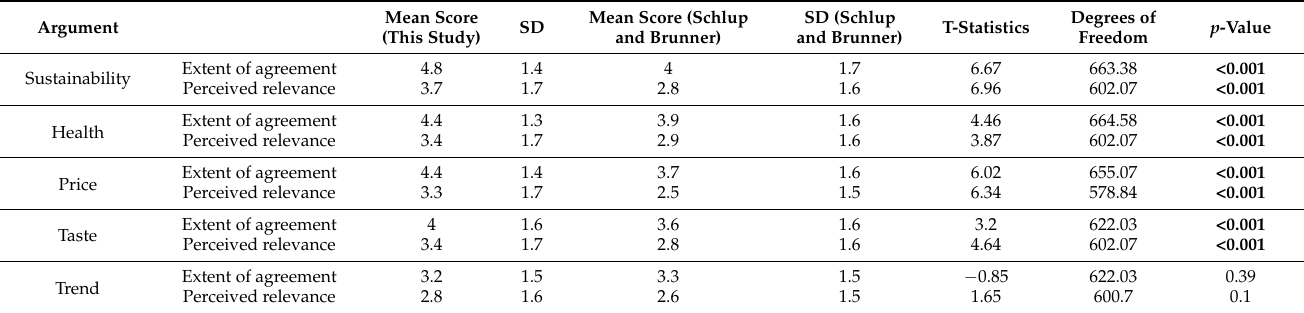
Table 7. Comparison of variables composing the acceptance score (ACI) obtained in the present study and those obtained by Schlup and Brunner, based on the participants’ responses